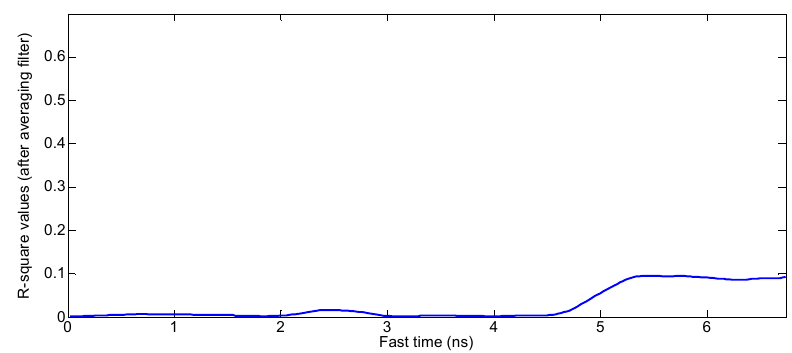
Figure 18. The R-square values in case of huge body movements (all the values are below the threshold value of 0.3).